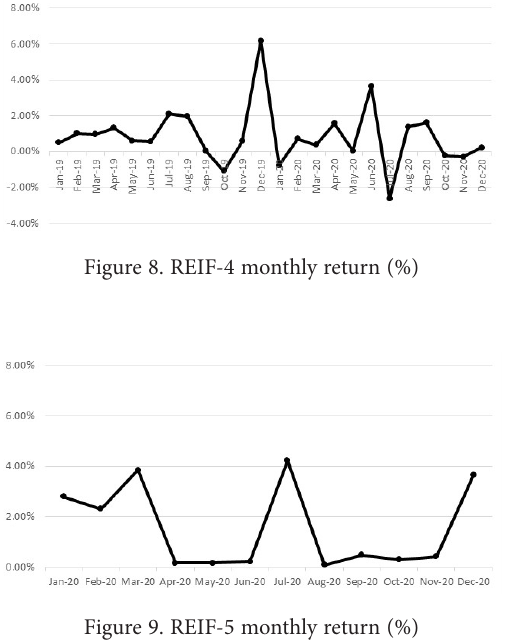
Figure 9. REIF-5 monthly return (%)